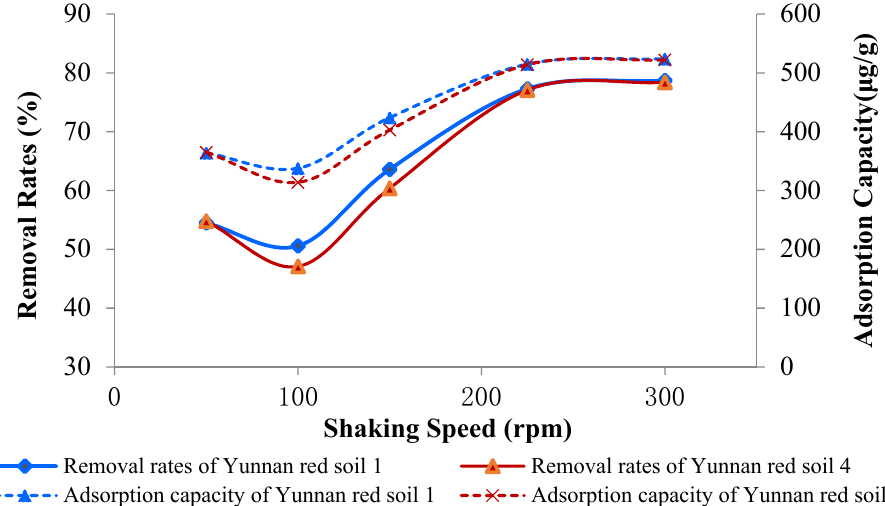
Figure 3. Effect of the Shaking Speed on the Adsorption Process.